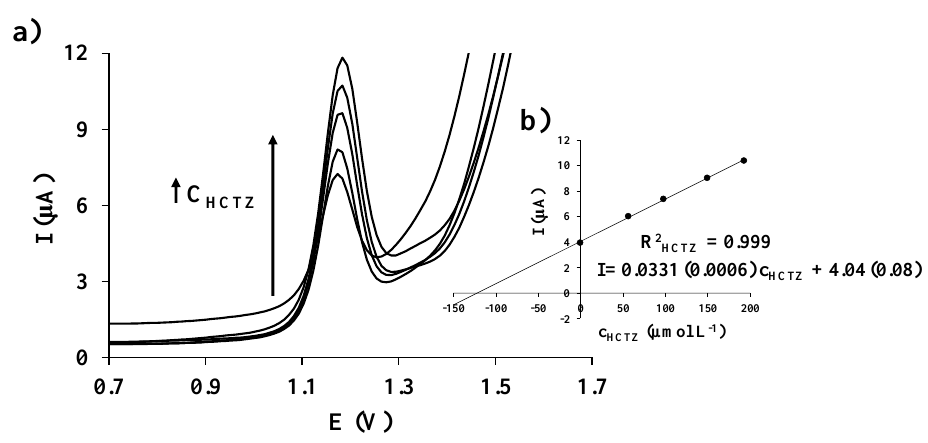
Figure 5. DP voltammograms measured with SPCE/EGA in HCl 0.01 mol L − 1 for an anti-hypertensive drug sample before and after four successive additions of a standard solution of HCTZ ( a ); and the corresponding HCTZ standard addition plot ( b ), including in parenthesis the standard deviations of the slope and the intercept.